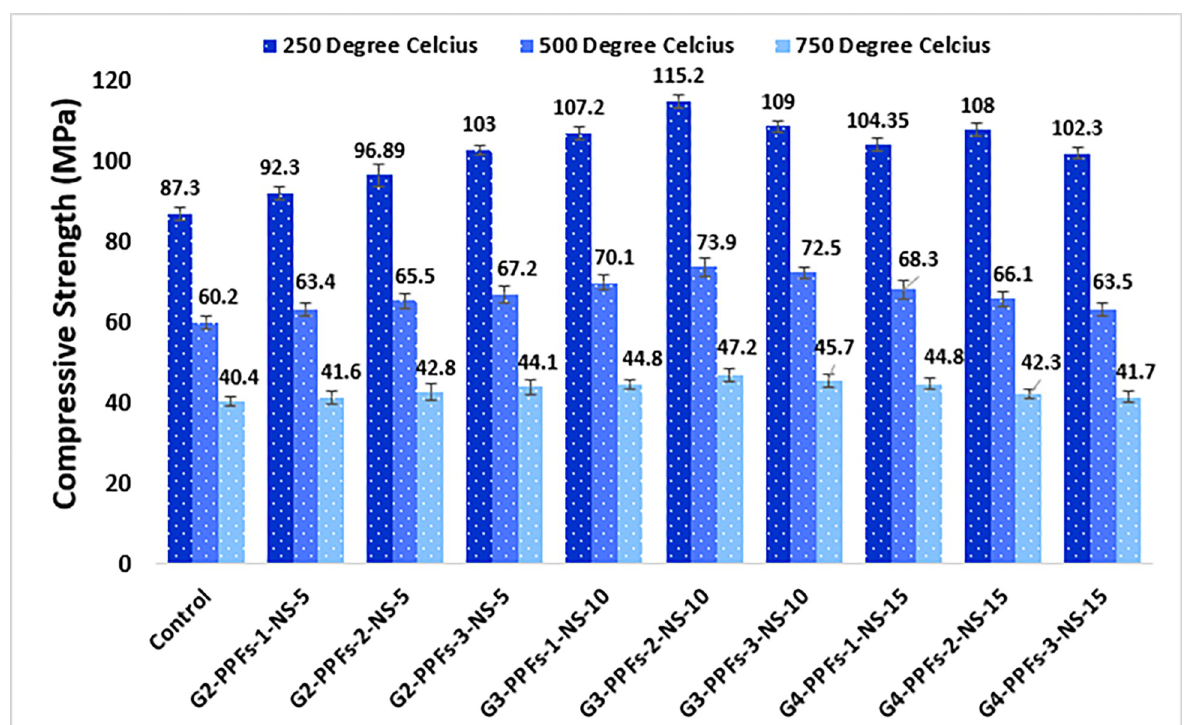
Fig 20. Compressive strength of UHS-GPC after elevated